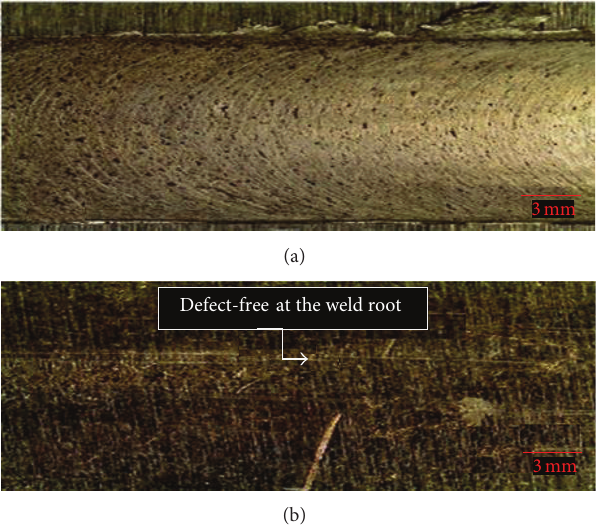
Figure 6: The weld profile of friction stir welded Al-Al joint at rotational speed of 2720 rpm and traverse speed of 45 mm/min at (a) top side and (b) bottom